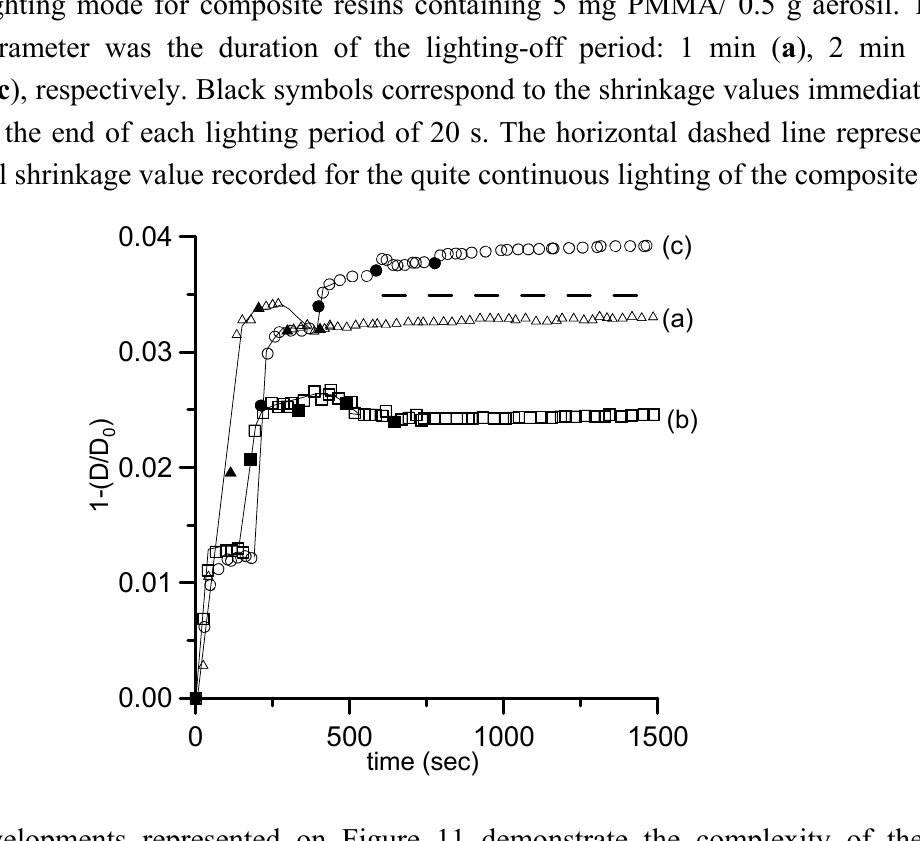
) resulting from the 0